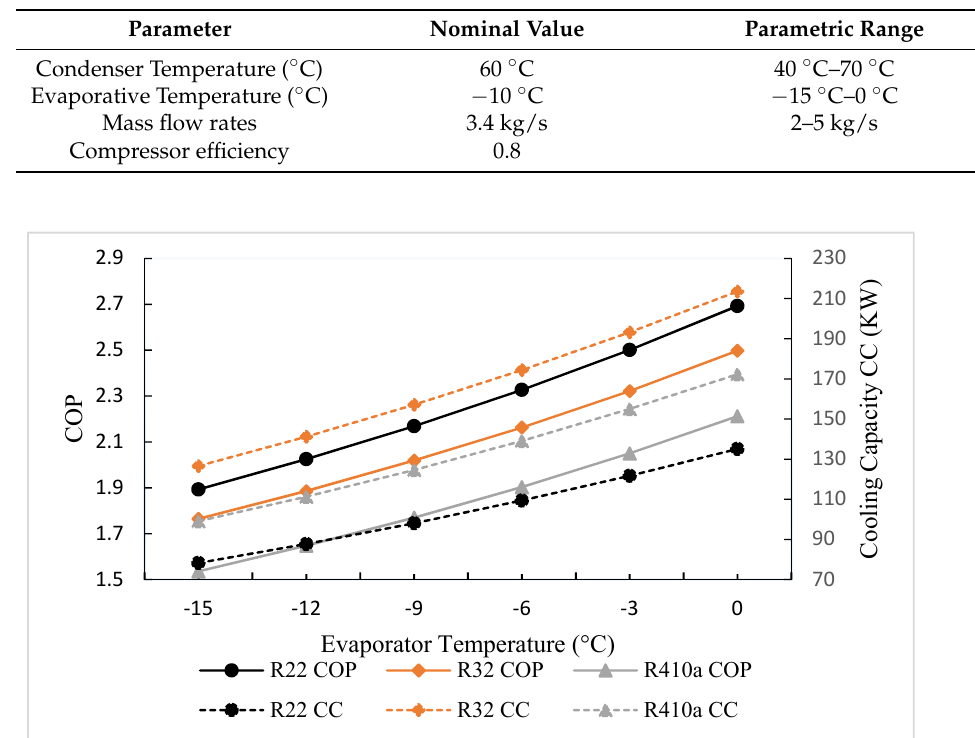
Figure 5. Variation of COP and cooling capacity versus evaporating temperature at constant con- denser temperature 60 ℃.